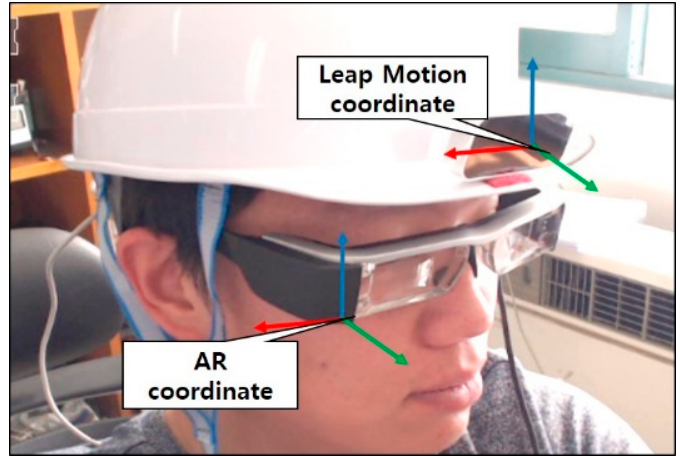
Figure 8. Difference between the wearable AR coordinate and the depth sensor coordinate. Figure 8. Di ff erence between the wearable AR coordinate and the depth sensor